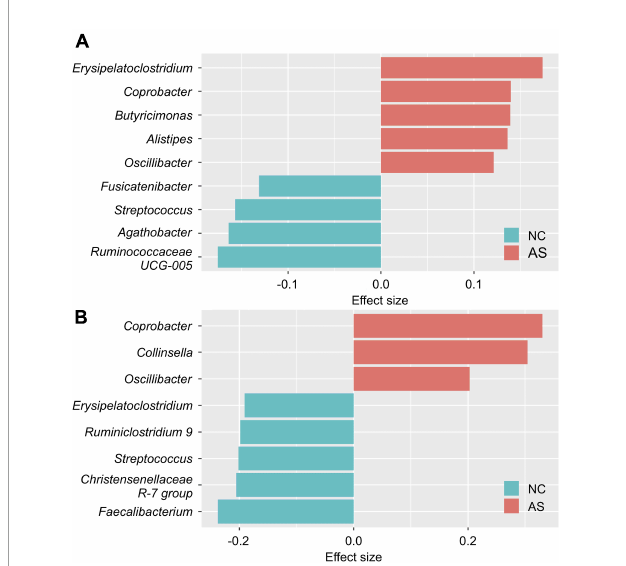
FIGURE2 Differences in the intestinal microbiome genera of healthy and atopic dermatitis-afflicted individuals. The effect size between the normal control group (NC) and patients with atopic dermatitis without other diseases (AS) was calculated separately for (A) females and (B) males using the aldex.effect function in the ALDEx2 package (version 1.24.0; Fernandes et al., 2013). The effect size was calculated 500 times and arranged in descending order based on the absolute value of the effect size. In this manner, we obtained 500 lists of the top 20 genera, and identified the genera intersecting all lists (nine genera for the females and eight for the males). The effect size value is the average value of the 500